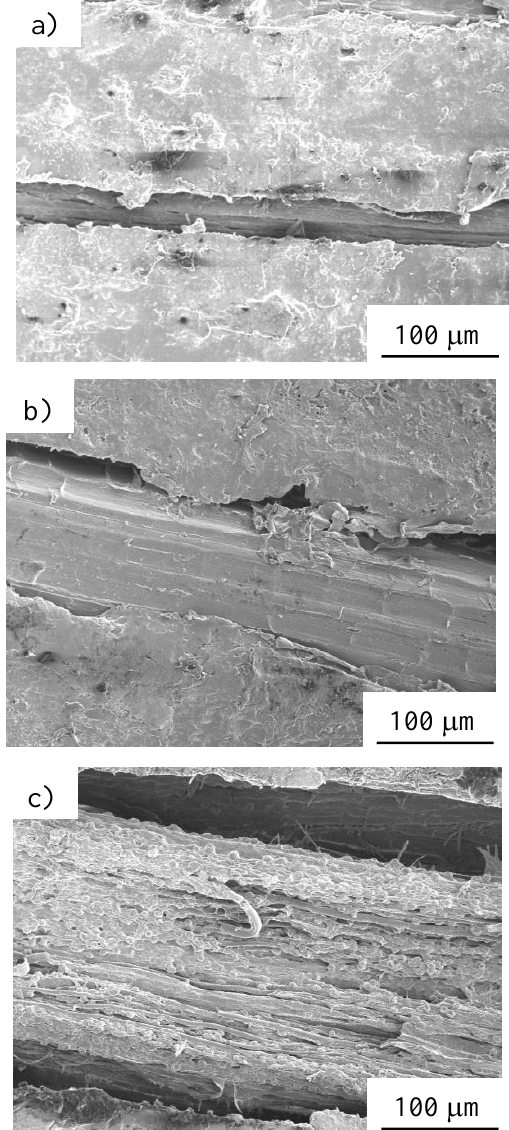
Figure 13. SEM photomicrographs of after composting test of MHFRP specimens after: a) 5, b) 10 and c) 30 days (under Condition